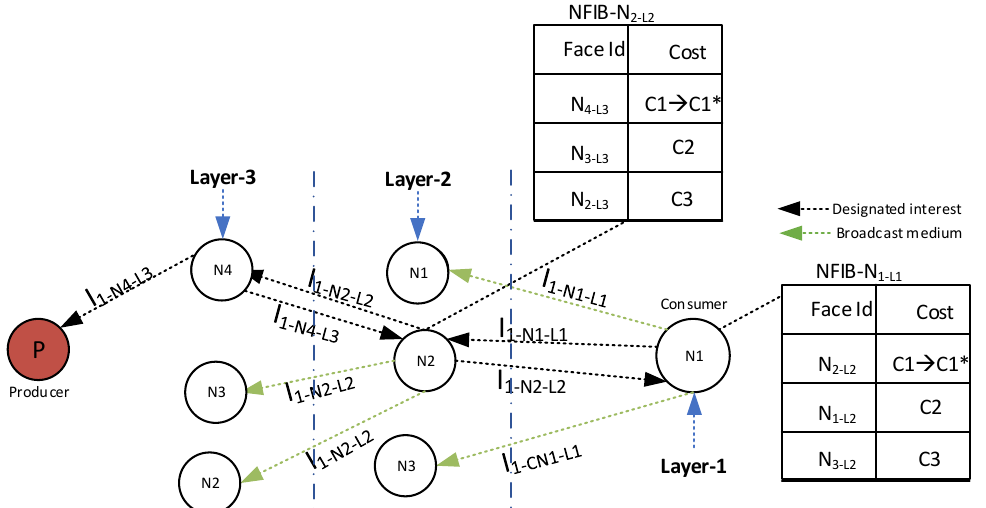
Figure 4. Downstream Interest packet